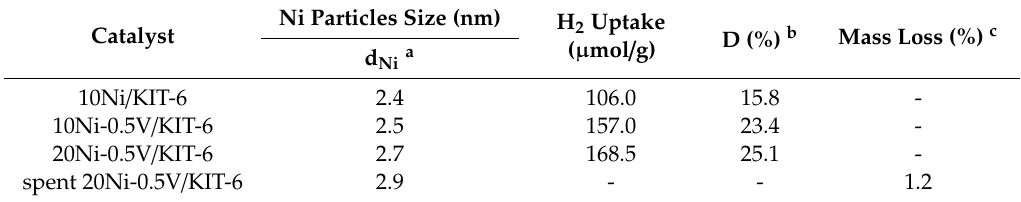
Table 1. Physicochemical properties of Ni-based catalysts.